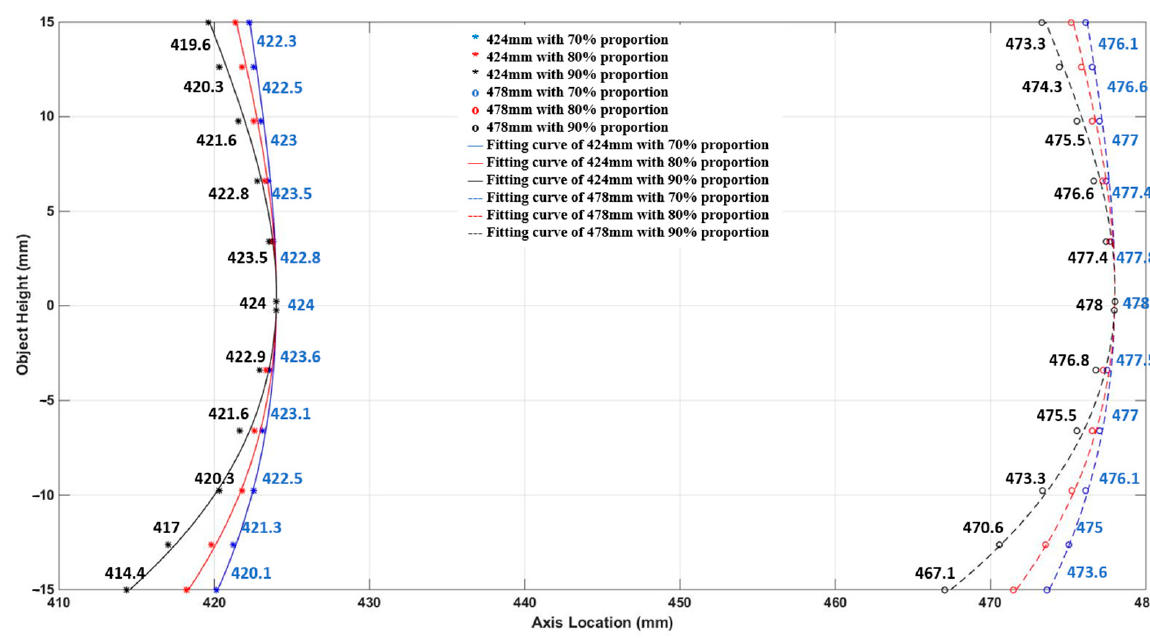
Figure 6. Point selection and fitting results.